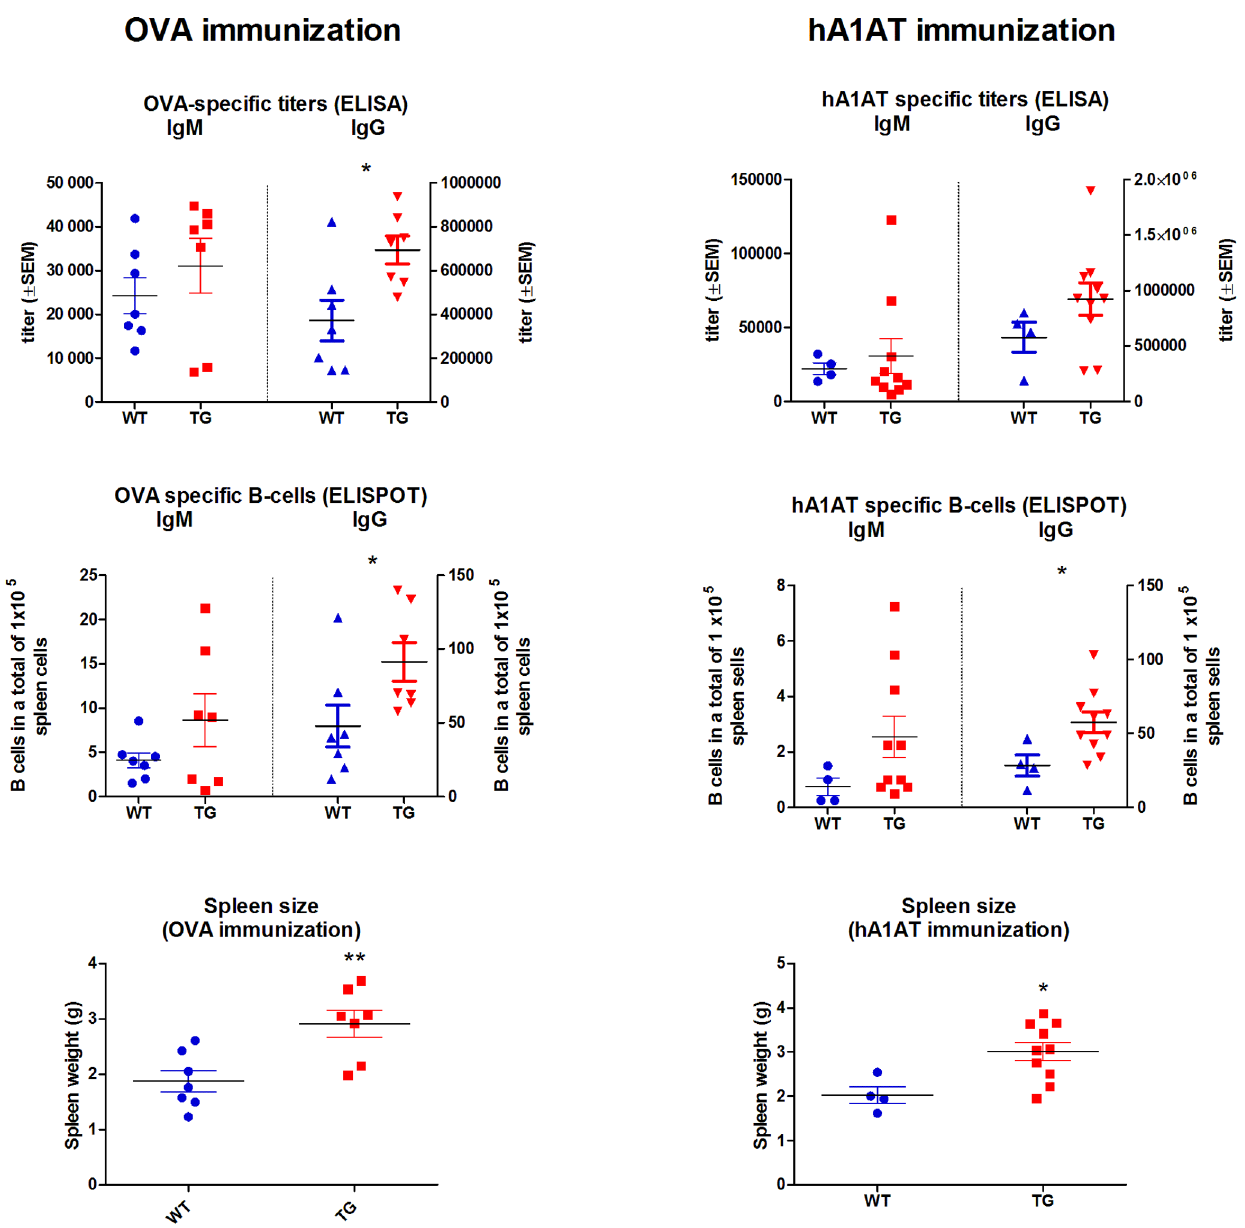
Figure 5. FcRn Tg rabbits have augmented antigen specific B-cell activation. Immunization with ovalbumin (OVA) and human a 1-anti- trypsin (hA1AT) resulted in generally higher level IgM and IgG titers measured by ELISA, more antigen specific IgM and IgG producing B cells determined by ELISPOT, and larger spleen in Tg rabbits as compared to their wt controls (* P , 0.05; ** P , 0.01).